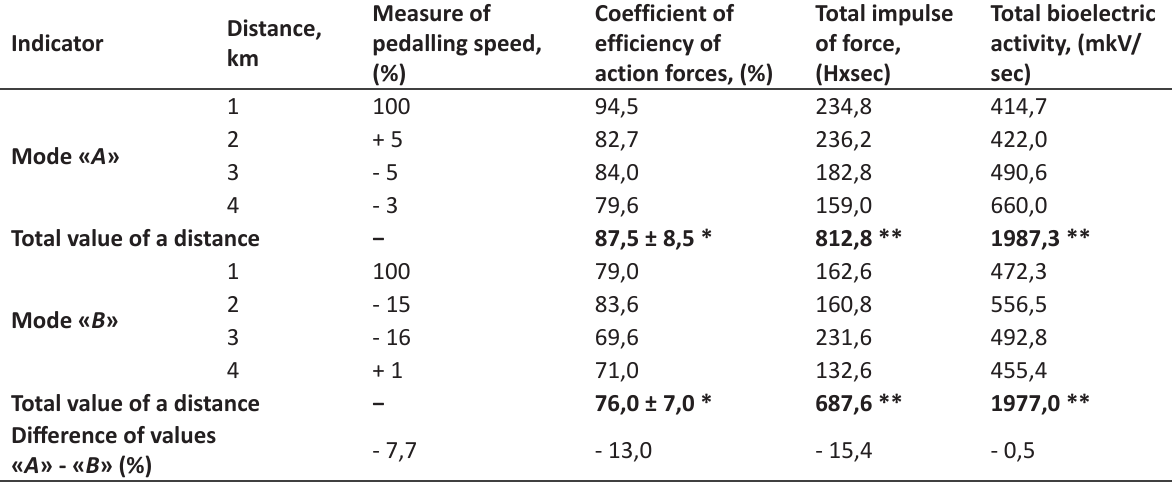
Table 1 . Indicators of pedalling speed dynamics, integrated biomechanical characteristics of cyclists motor actions in passing a 4 km distance